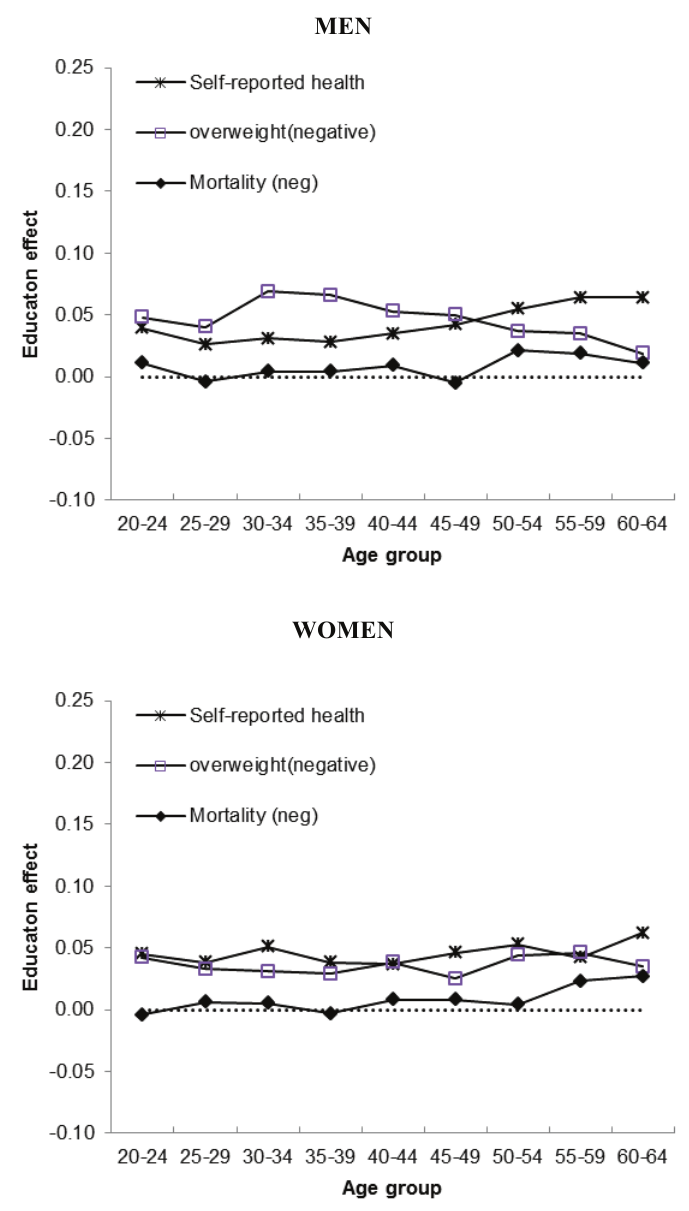
Fig. 3-4 Age variation in the relationship between education and health. Notes: The size of the education effect is on the y-axis and the x-axis describes the age groups. The education effects for the age groups are estimated in a pooled OLS model (see equation 1). For comparability we change the sign of the education effects on overweight and mortality; otherwise these relationships go in the opposite direction compared to self-reported